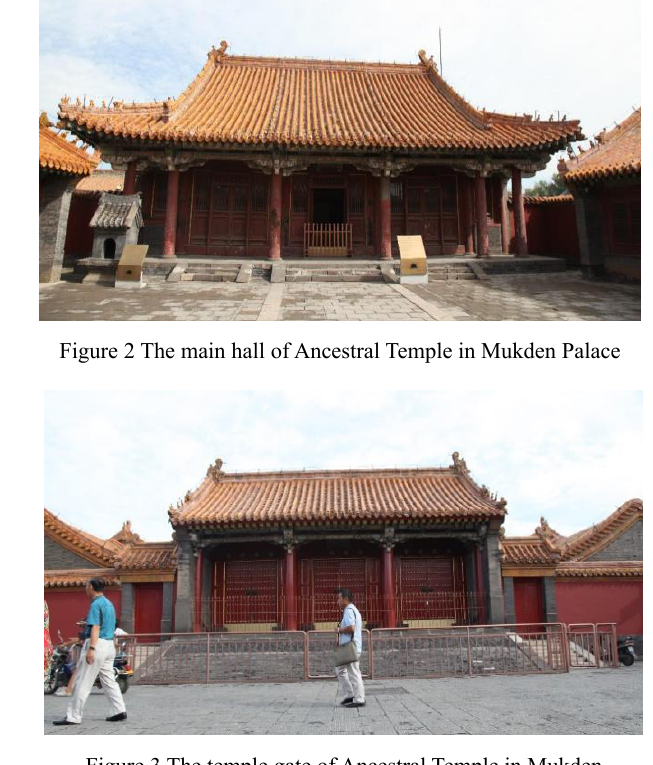
Figure 3 The temple gate of Ancestral Temple in Mukden